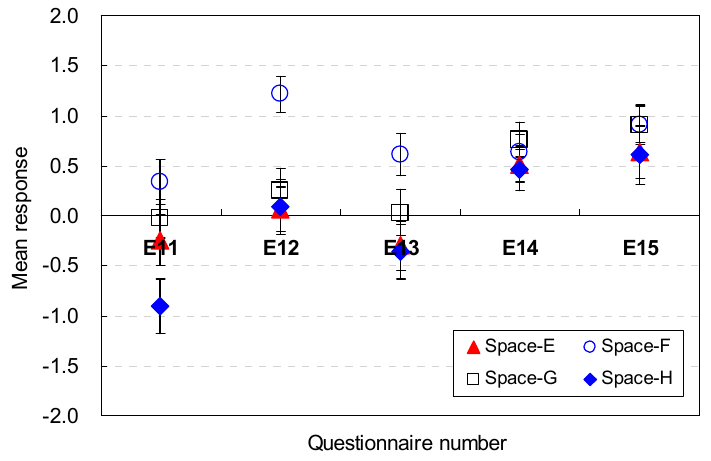
Figure 17. Spatial perception of the spatial configuration in terms of efficiency under floor layout changes.